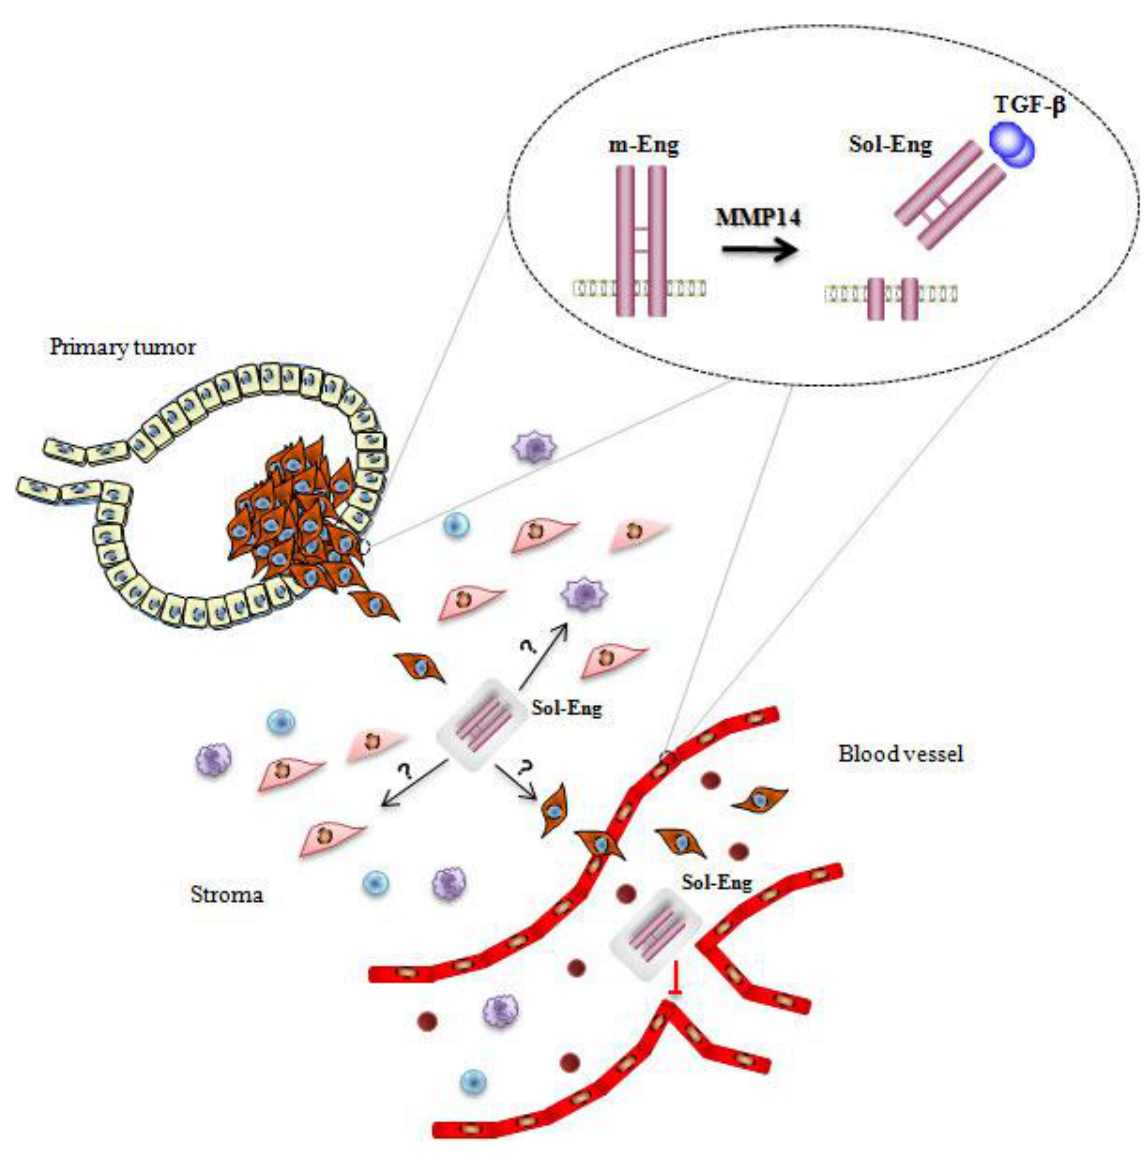
FIGURE 3 . Generation of Sol-Eng in tumors and its possible actions. The proteolytic cleavage of membrane endoglin (m-Eng) to release Sol-Eng can occur in the primary tumor as well as in the stroma and blood vessels. It has been shown that Sol-Eng inhibits angiogenesis, but its effects on the behavior of tumor cells, cancer- associated fibroblasts (pink), and inflammatory cells (blue and purple) have not yet been tested.